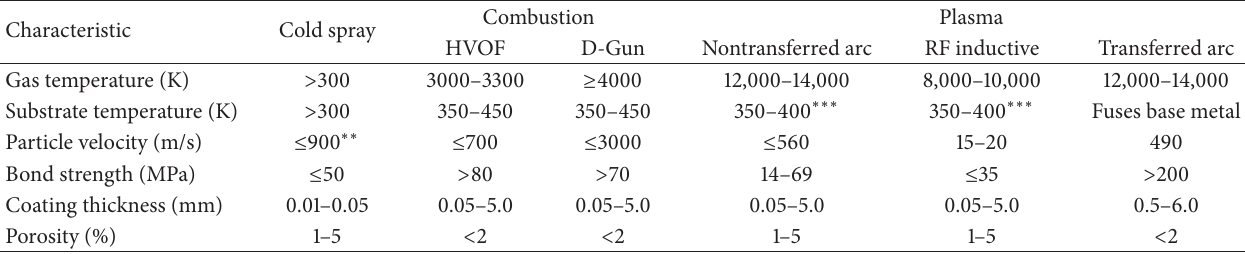
Table 1: A summary of a selection of characteristics of thermal spray processes ∗